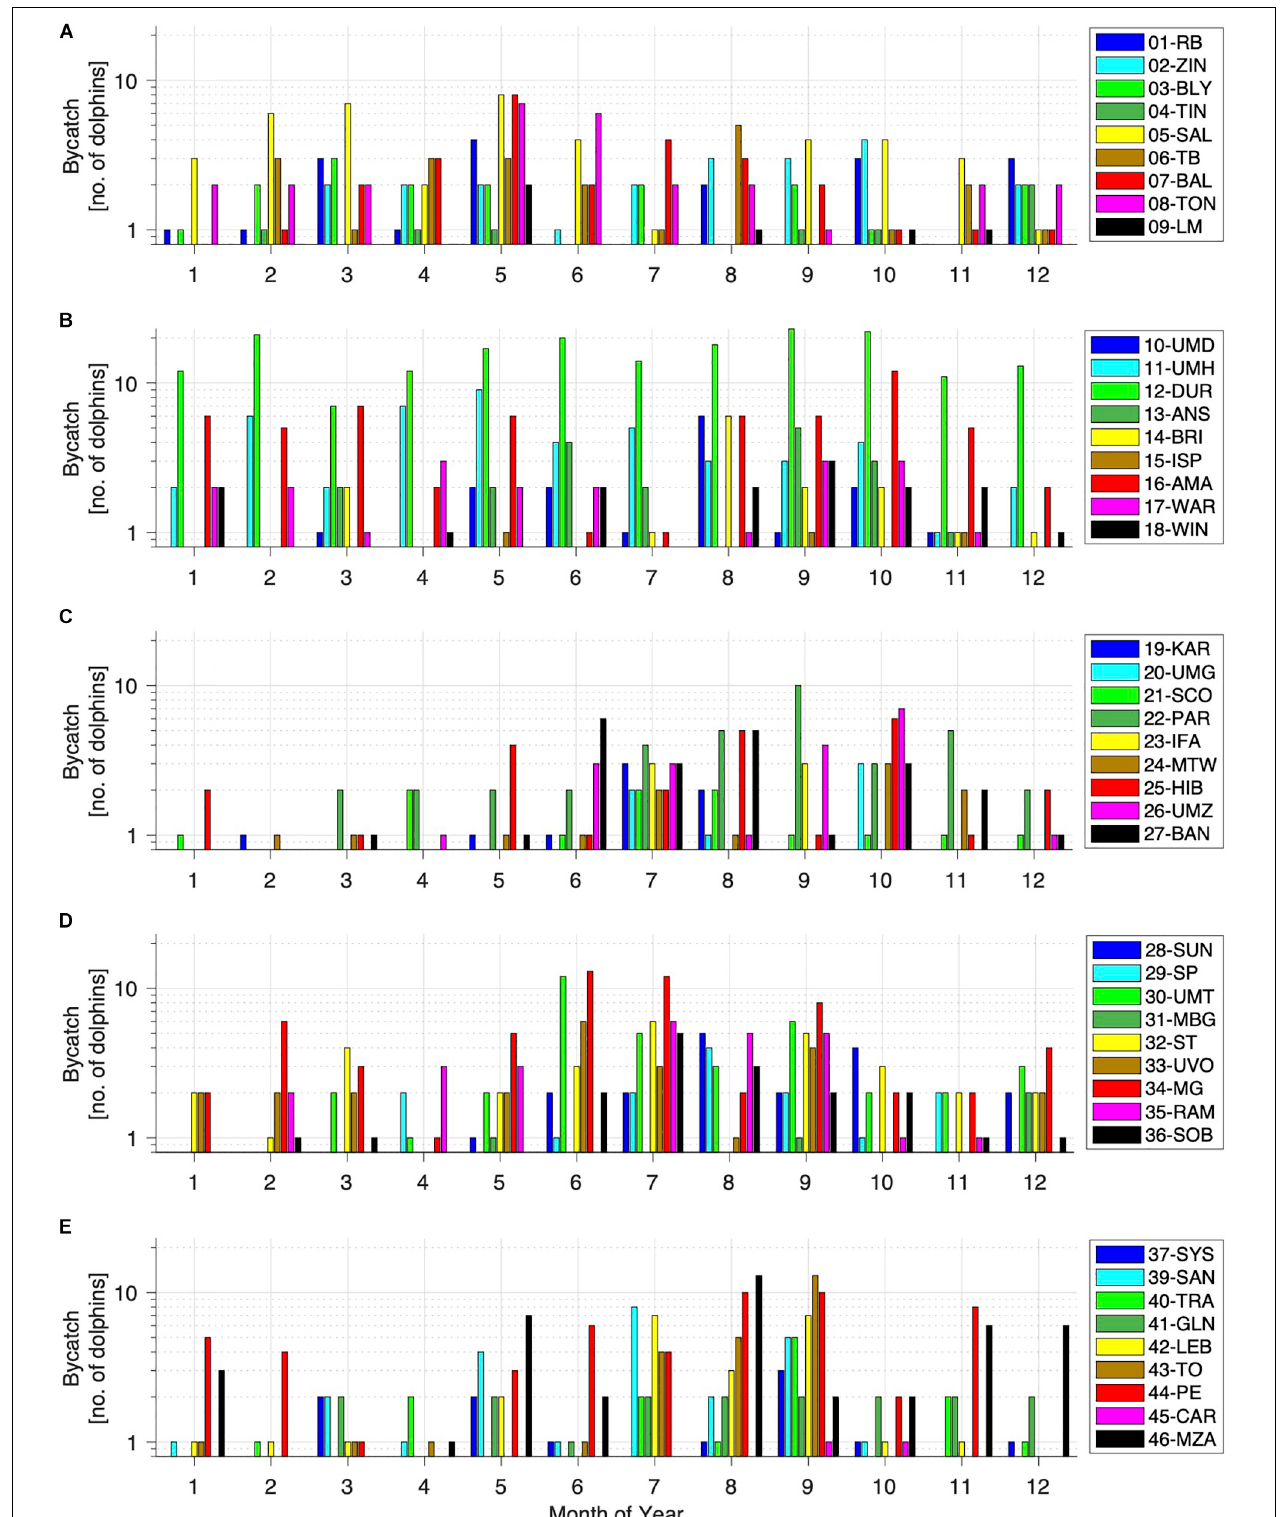
FIGURE 4 | Monthly bycatch of T. aduncus calculated as totals across the entire period (1980–2015) per location (beach). Beaches are organized from North to South ( A–E : 1–46). Note the logarithmic y-axis to better show low catches.